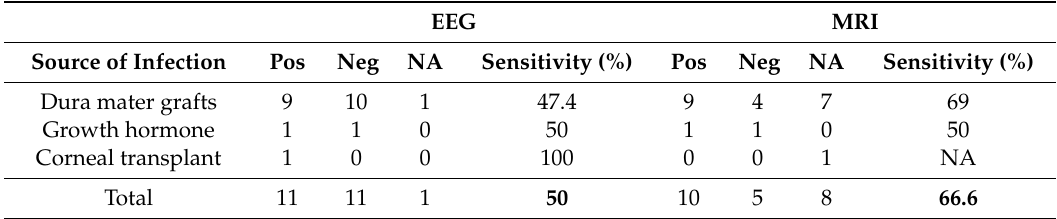
Table 2. Electroencephalogram and magnetic resonance imaging in iatrogenic CJD. Source of infection, electroencephalogram (EEG), and magnetic resonance imaging (MRI) outcome given as positive (Pos), negative (Neg), or not available (NA), and sensitivity of the biomarker test (%), are indicated.